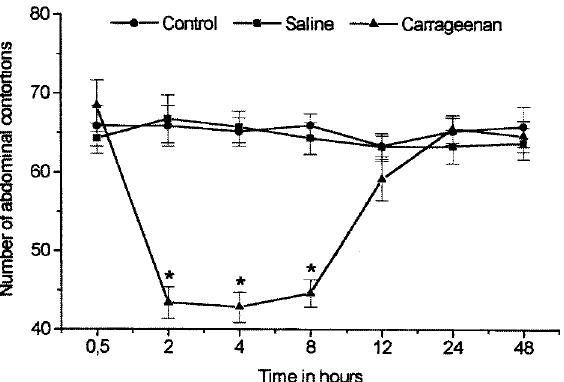
FIG. 3. Effect ofmAb anti-granulocytes (anti-Gr–1) on anti- nociception induced by carrageenan (Cg) in animals sub- mitted to the writhing test. ThemAb anti-Gr–1 was injected 36h before the i.p. injection of Cg and 2, 4 or 8h later submitted to the writhing test. Animals injected with non relatedmAb were also evaluated. Controls were injected only with acetic acid. Values represent the mean ±S.E.M. of 8–16 animals for each group. * p < 0.05 in comparison with values obtained in control animals. ** p < 0.05 in comparison with the group treated with non relatedmAb +